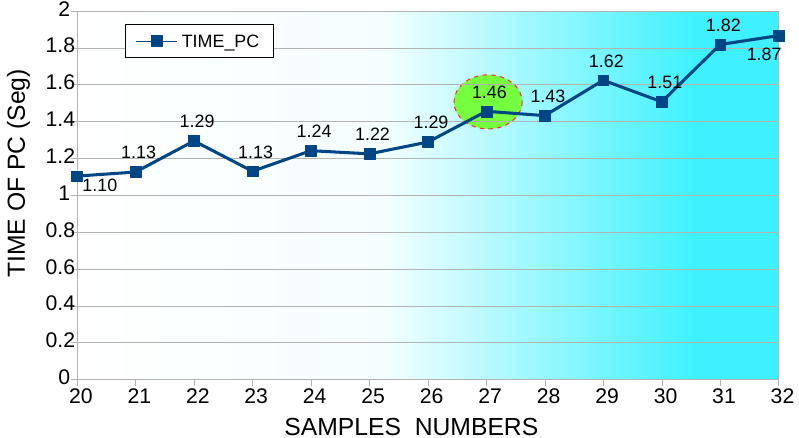
Figure 14. Machine time, number of periods constant at 20, varying the number of samples per cycle from 20 to 32